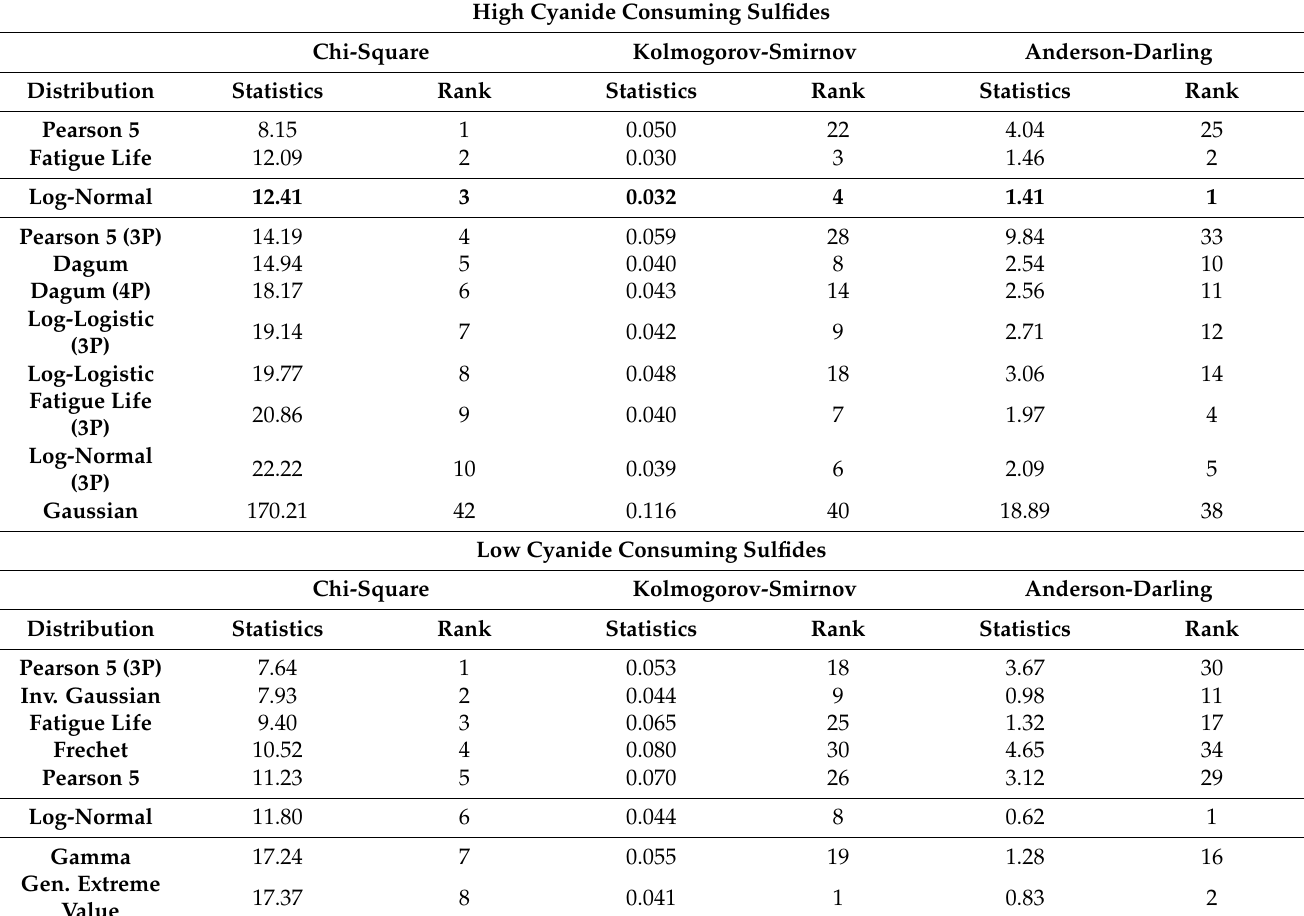
Table 4. Ranking of distributions in accordance with GOF metrics. High Cyanide Consuming